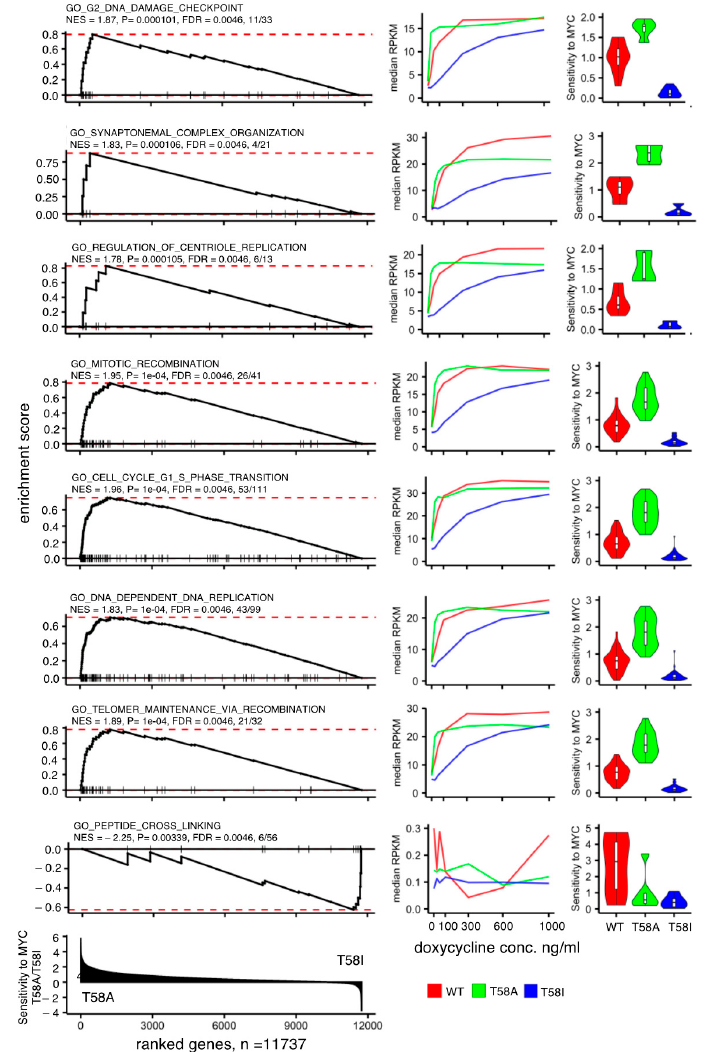
Figure 7. Enriched pathways for genes with sensitivity differences to the levels of MYC T58A and MYC T58I. Representative examples of gene sets that are significantly enriched in a gene set enrichment analysis (GSEA) of genes ranked according to the extent of their sensitivity to T58A MYC in relation to T58I MYC. Left panels: GSEA plots showing a running sum statistic that increases when genes in the ranked list are present in the functional gene set tested. The position of these genes in the rank is indicated by vertical lines. The red dashed line shows the enrichment score value (ES, maximum value of the running sum score). The analysis was performed on 11,737 genes for which human orthologues could reliably be identified and the sensitivity-based rank is shown in the lowest plot. The pathway name is indicated above each plot followed by the normalized enrichment score (NES), GSEA p -value, false discovery rate adjusted p -value (FDR) and the number of genes in the GSEA leading edge (interval between the start of the rank and the gene where ES is attained) in relation to the number of genes in the pathway. Middle panel: Expression-level plots showing median reads per kilobase per millions of reads (RPKM) values for leading edge set of genes identified for each GSEA gene set. Median RPKM values for WT MYC (red), T58A MYC (green) and T58I MYC (blue) at different doxycycline levels (0, 25, 50, 100, 300, 600 and 1000 ng/mL) are plotted. Right panels: Violin plots showing the MYC-level sensitivity of the leading-edge genes in the indicated pathway for WT MYC (red), T58A MYC (green) and T58I MYC (blue). Sensitivity was determined by the change in absolute fold change between the fold change between 0 and 25 ng/mL and the fold change between 300 and 600 ng/mL of doxycycline (FC 25/0 /FC 600/300 ).